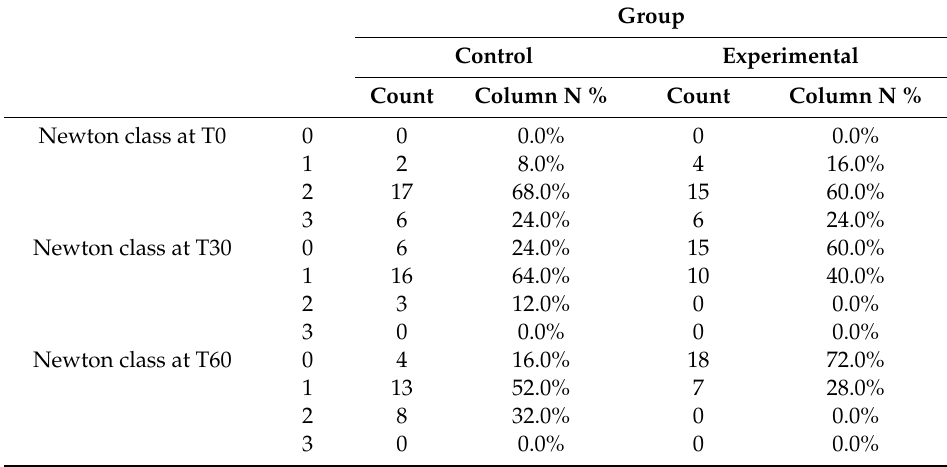
Table 2. Distribution of denture stomatitis (DS) (according to Newton’s classification) between the study and control groups at T0 ( p = 0.665), T30 ( p = 0.005) and T60 ( p <